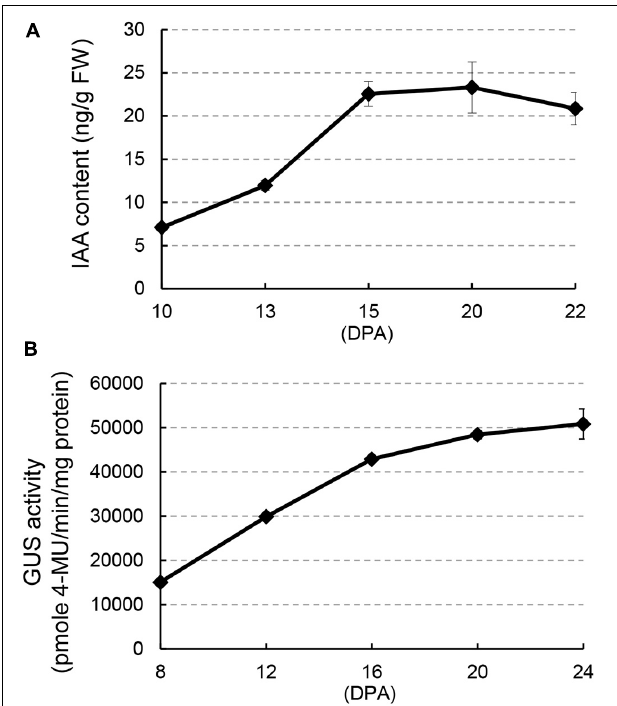
FIGURE 1 | Auxin level increases in fiber cells during the transition between elongation and cell wall secondary growth onset. (A) Free indoleacetic acid (IAA) content in developing fibers at different days post-anthesis (DPA). (B) GUS activity in developing fibers of DR5:GUS cotton. Error bars indicate standard deviation of three biological